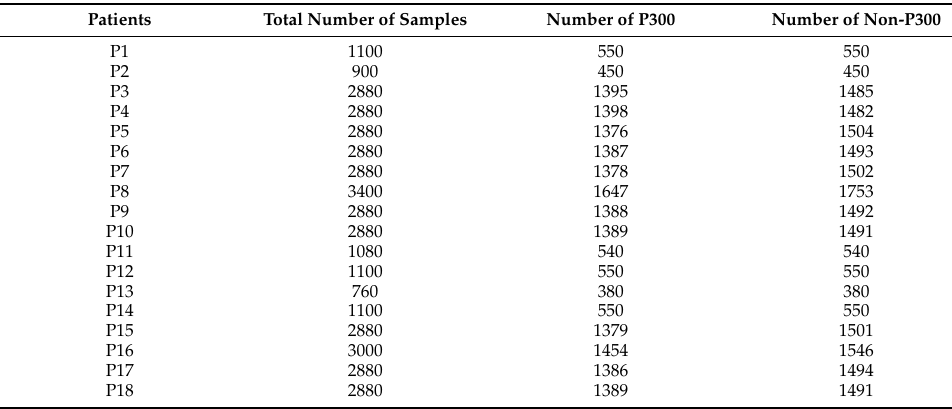
Table 2. EEG sample information for all